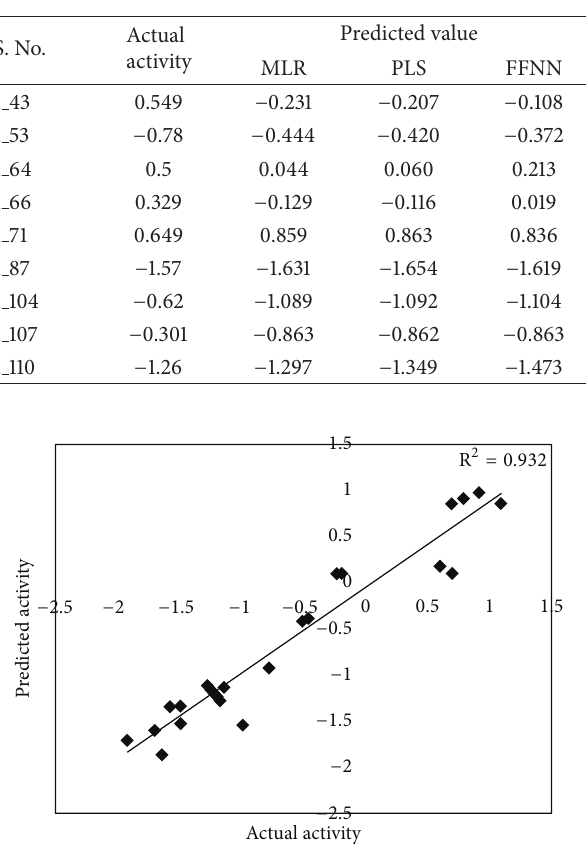
Figure 1: Plot of actual versus predicted values for the training set molecules with the help of MLR statistical